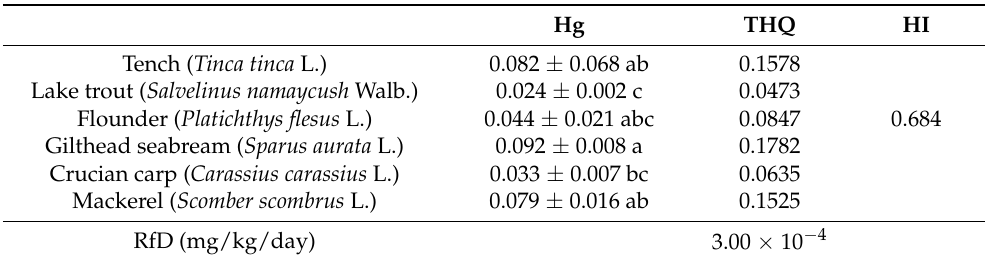
Table 1. Differences (x ± SD) in the content of mercury (mg/kg wet weight) in muscle tissue of fish and indices (THQ and